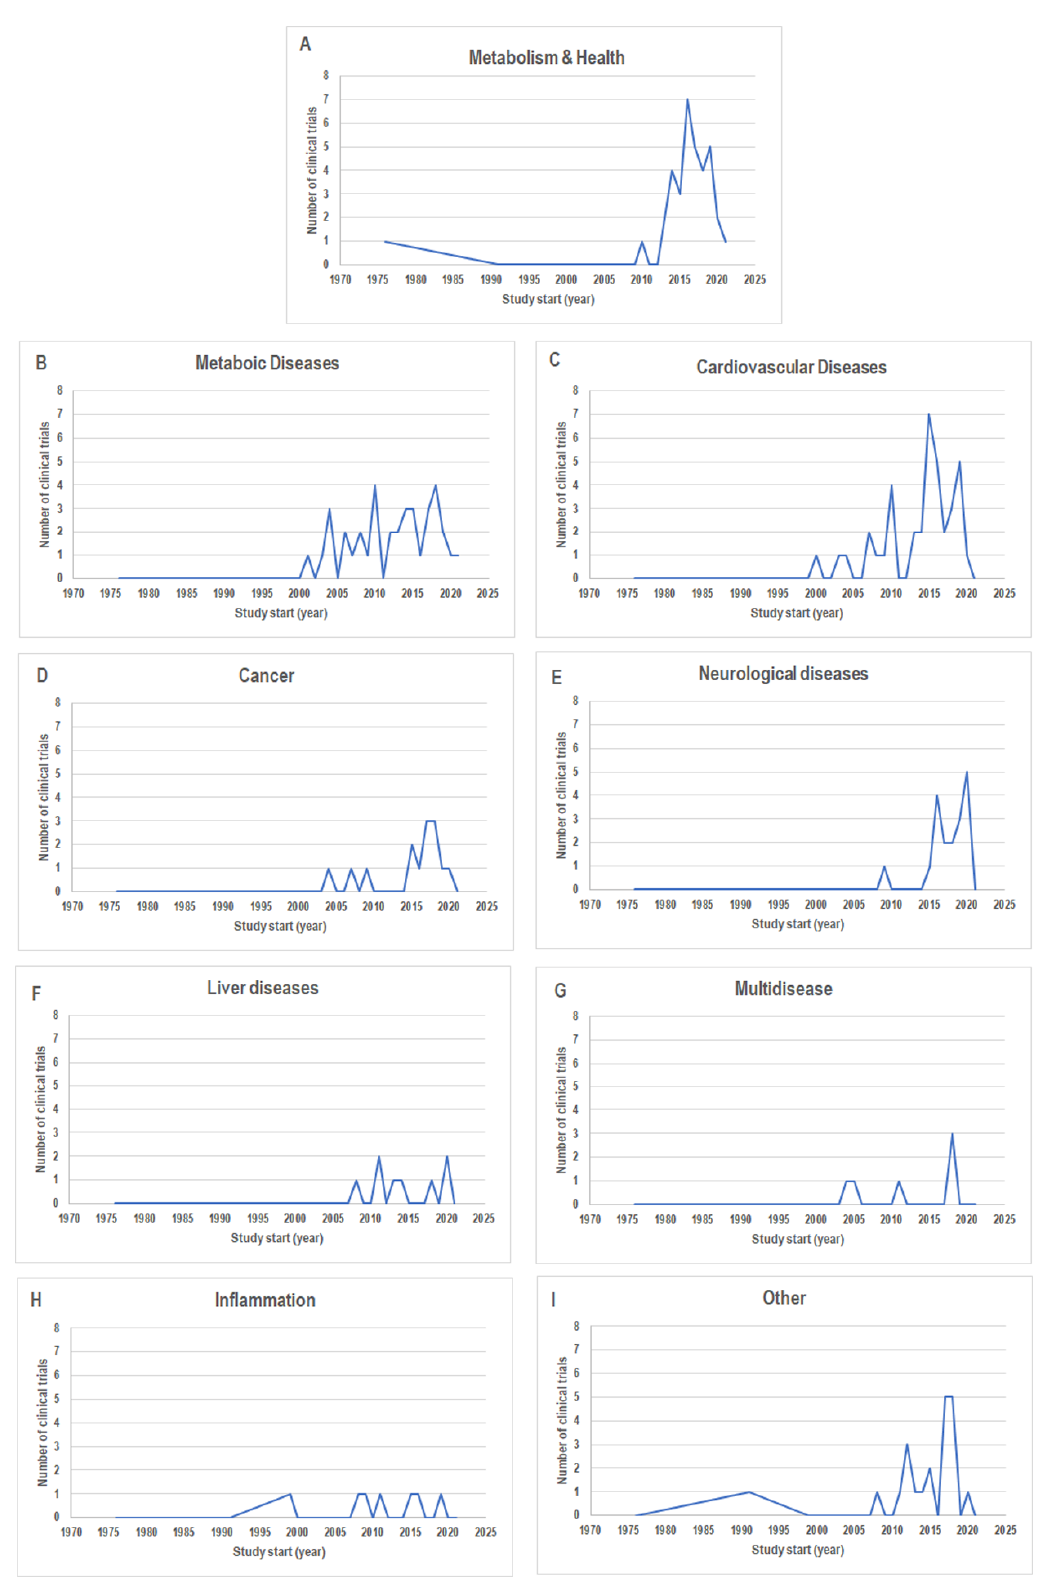
Figure 4. The number of clinical trials for each category classified according to “Study Start” as follow: ( A ) Metabolism & Health; ( B ) Metabolic Diseases; ( C ) Cardiovascular Diseases; ( D ) Cancer; ( E ) Neurological Diseases; ( F ) Liver Diseases; ( G ) Multidisease; ( H ) Inflammation; ( I ) Other. Data from http://www.clinicaltrials.gov/ (accessed on 31 January 2022).